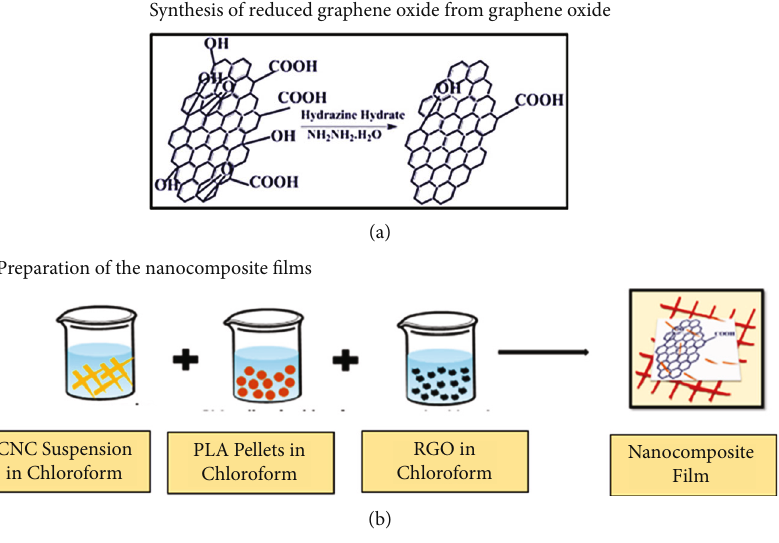
Figure 2: (a) Synthesizing of minimal quantum of graphene oxide and (b) nanocomposite fi lm formation.